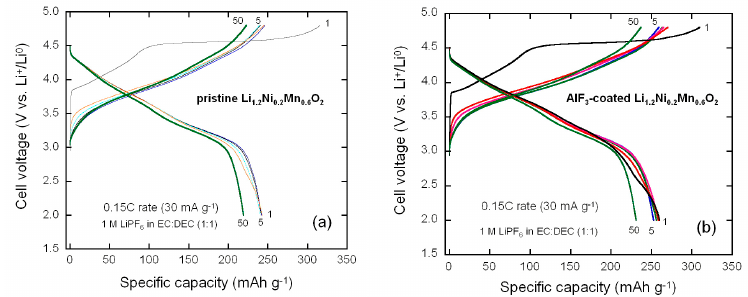
Figure 9. Galvanostatic charge-discharge of ( a ) pristine LLNMO and ( b ) AlF 3 -coated LLNMO. Cycles were carried out at 30 mA g − 1 current density (0.08C rate) in the potential range 2.0–4.8 V.